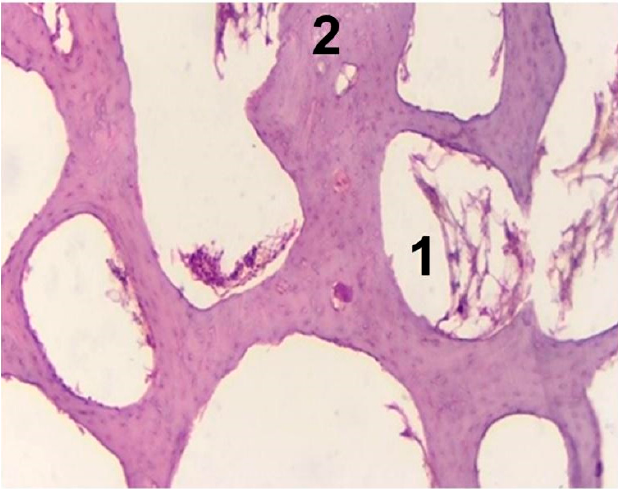
Figure 7. Histopathological sections in cortical area of femur (control group after 3 months, original magnification 10.0×). Legend: 1—the bone marrow vascular niche; 2—old bone. Table 3. Bone formation score for experimental and control groups after 2 and 3 months of implantation according to histological scoring scale presented in Table 1.